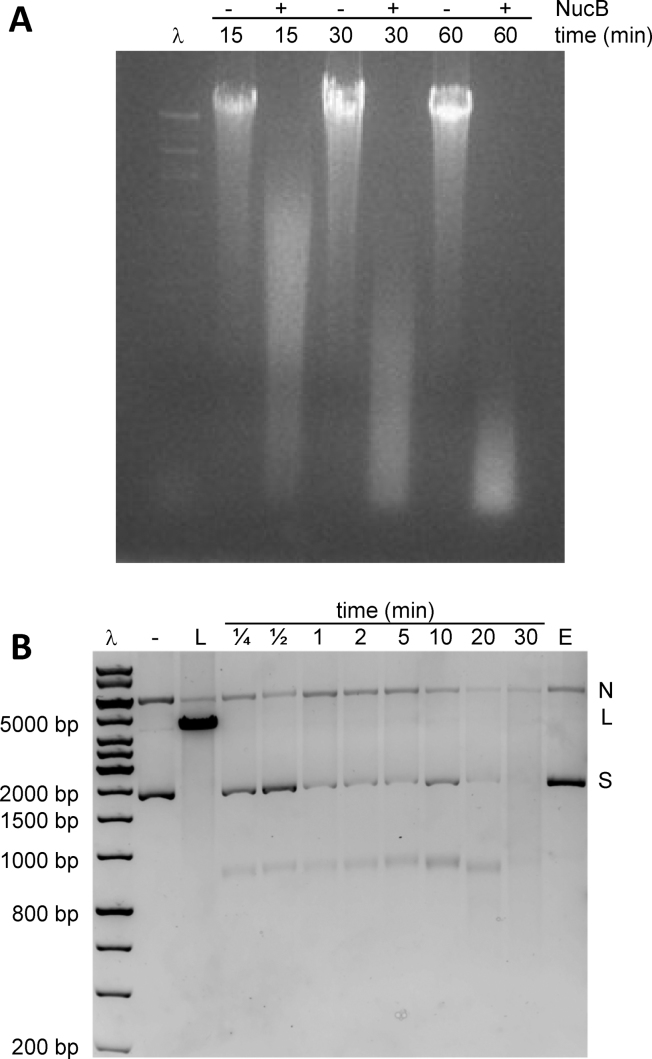
The nuclease activity of BlNucB against high molecular weight DNA. (A) BlNucB was incubated with (+) and without (–) calf thymus DNA for 15, 30 and 60 min at 37°C for 1 h. Samples of the digestion products were separated by agarose (0.8% w/v) gel electrophoresis and the DNA made visible by staining with ethidium bromide. HindIII-digested λ DNA (λ) is included as a marker. (B) BlNucB was incubated with a mixture of nicked (N) and supercoiled (S) pBR322 DNA at room temperature for 15 s, 30 s, 1 min, 2 min, 5 min, 10 min, 20 min and 30 min (labeled ¼ to 30 min). 10 mM EDTA (E) was added to the reaction mix prior to the addition of BlNucB for 30 min. Undigested (–) and BamHI-linearized (L) pBR322, along with HindIII-digested λ DNA (λ) are included as markers. The digestion products were separated by agarose (0.8% w/v) gel electrophoresis and the DNA made visible by staining with GelRed.